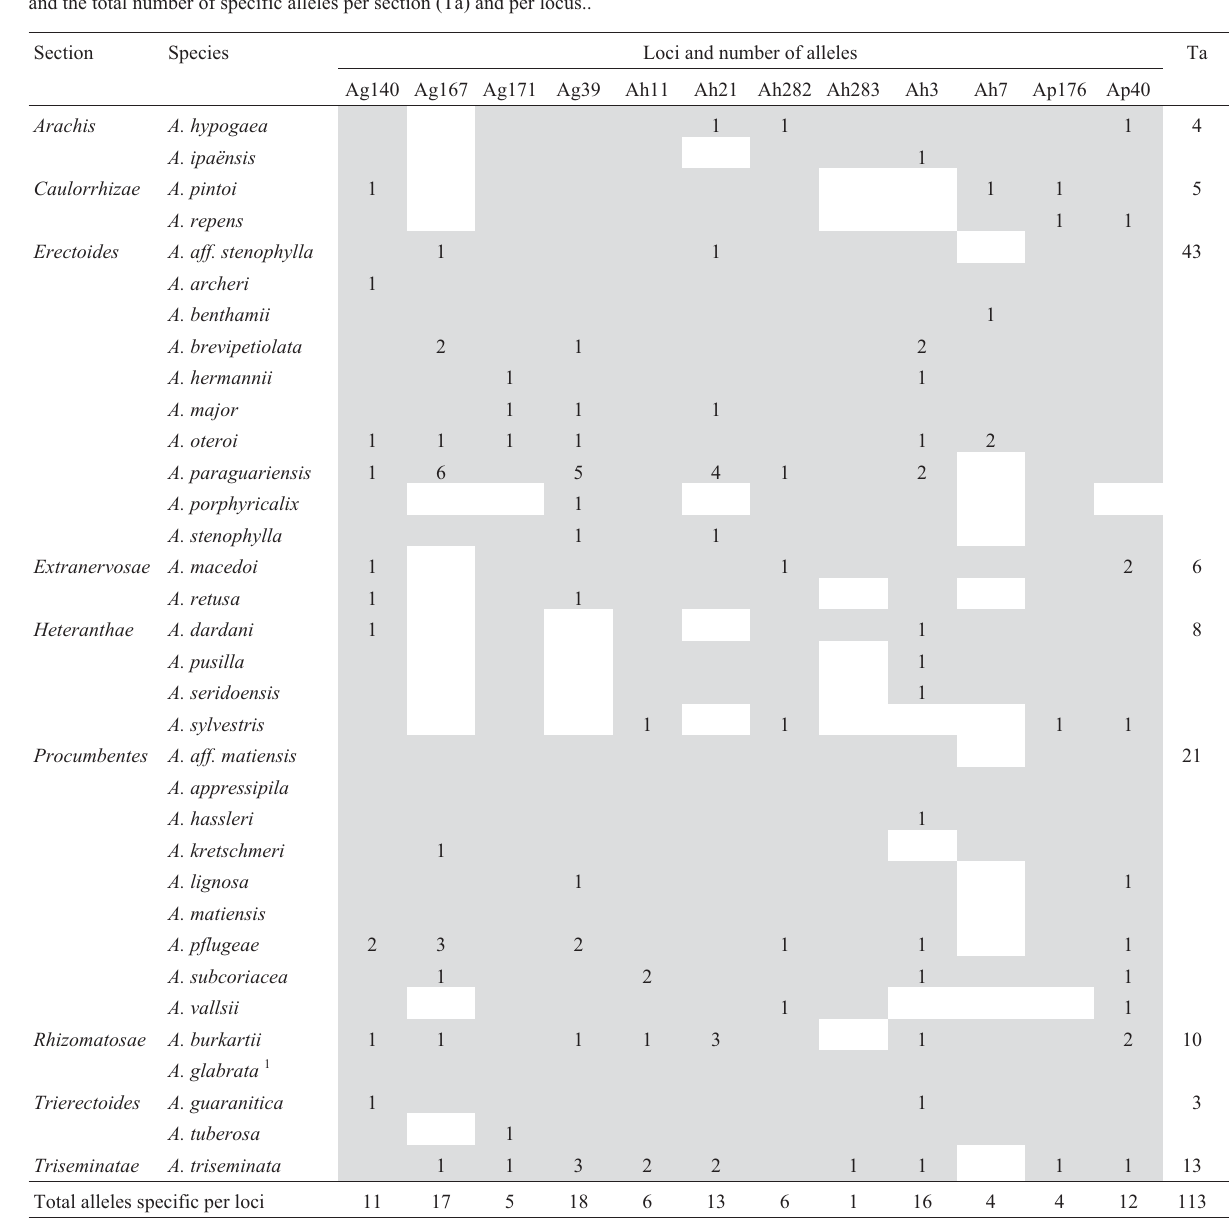
Table 3 - Amplification pattern (shaded) of various species of different sections of the genus Arachis showing the number of alleles specific to a species and the total number of specific alleles per section (Ta) and per